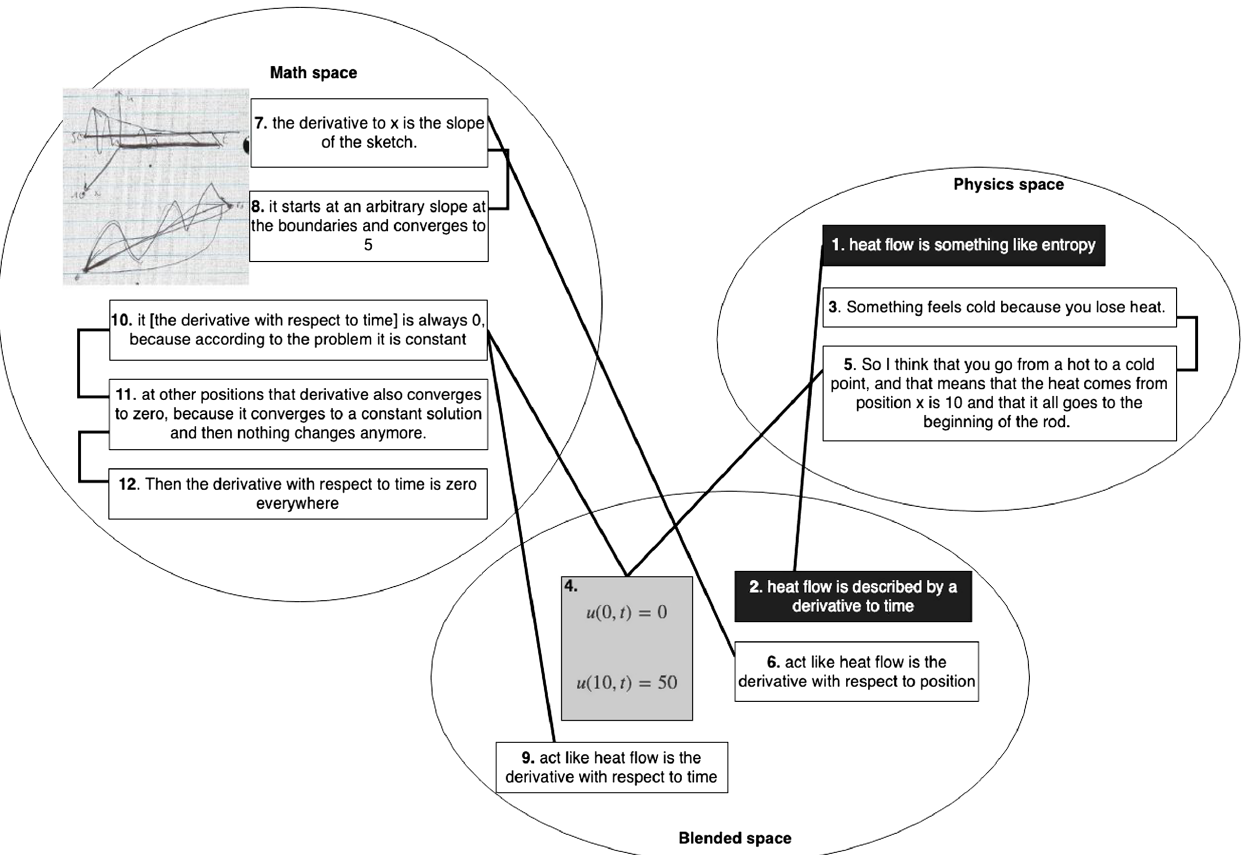
FIG. 11. DBD 3: David and Evan ’ s answer to question